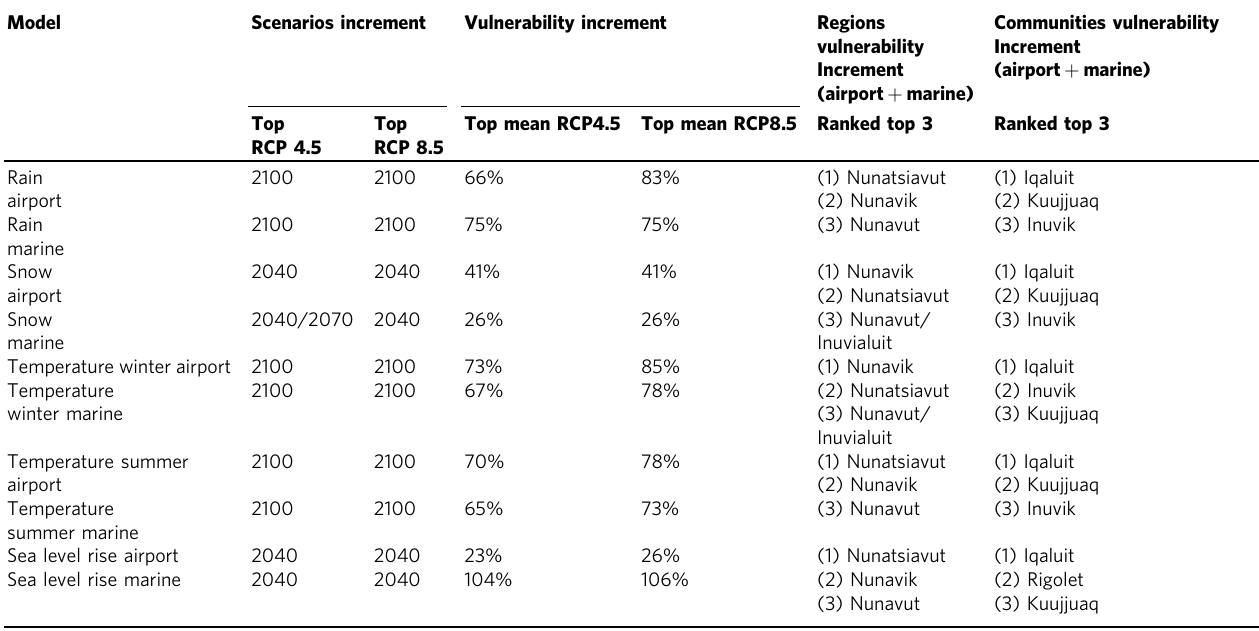
Table 4 Increment percentage/anomalies results for all models, scenarios and for the top 3 regions and communities